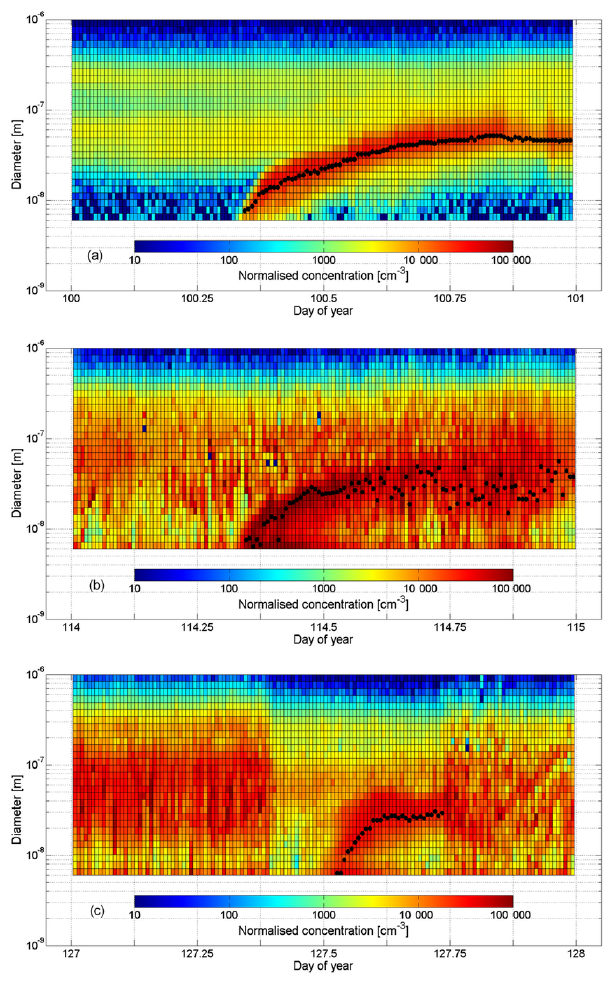
Figure 8. Banana-shaped size distribution surface plots for regional NPF and consecutive particle growth with narrow onset (a) in the near-city background on Monday, 9 April 2012, in a polluted urban air within the street canyon (b) on Sunday, 24 April 2011, and ap- pearing at a certain time (c) in the street canyon on Saturday, 7 May 2011. Time series of the fitted particle number median mobility di- ameter for the nucleation mode are indicated by black dots on each panel.